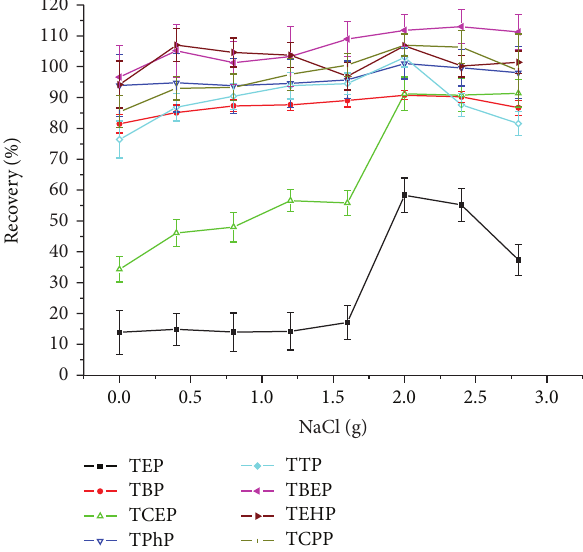
Figure 7: Optimization of amount of